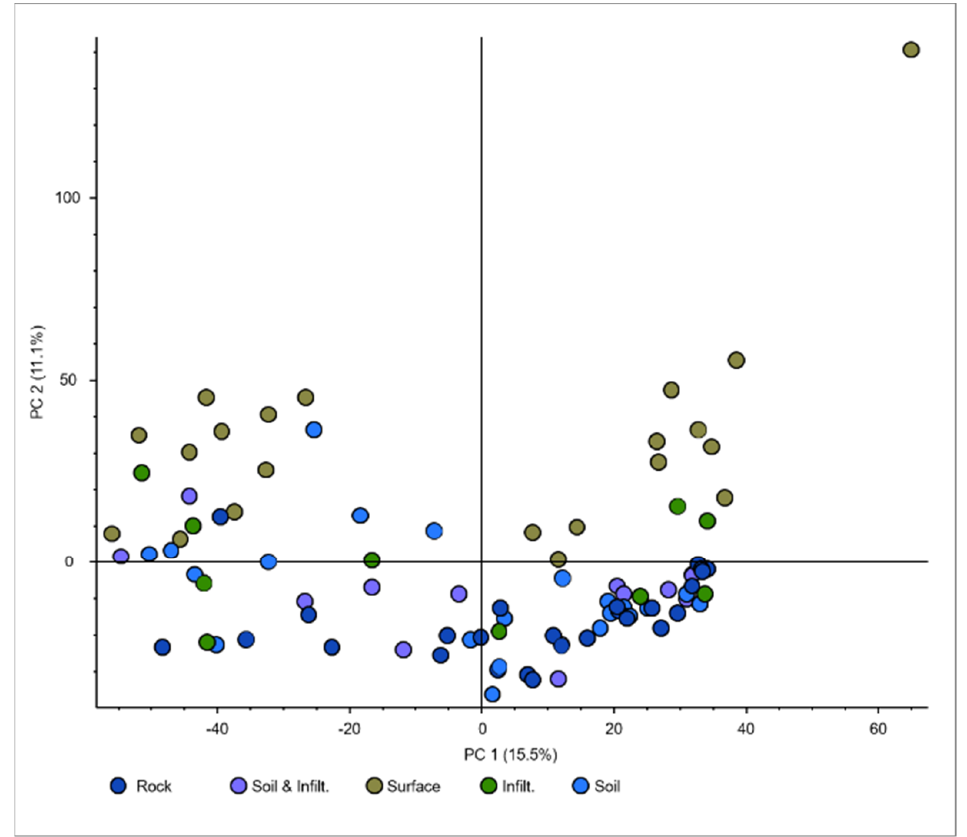
Figure 6. PCA score plot of HRMS-data of DW from 90 Swedish DWTPs sampled once in January–February 2018. The samples are labeled according to the type of RW supply. The five main groups are surface water, rock aquifer, soil aquifer, artificial infiltration, and finally DWTPs that use a combination of soil aquifer and artificial infiltration for the production of the DW. Contribution ratios in brackets (%).